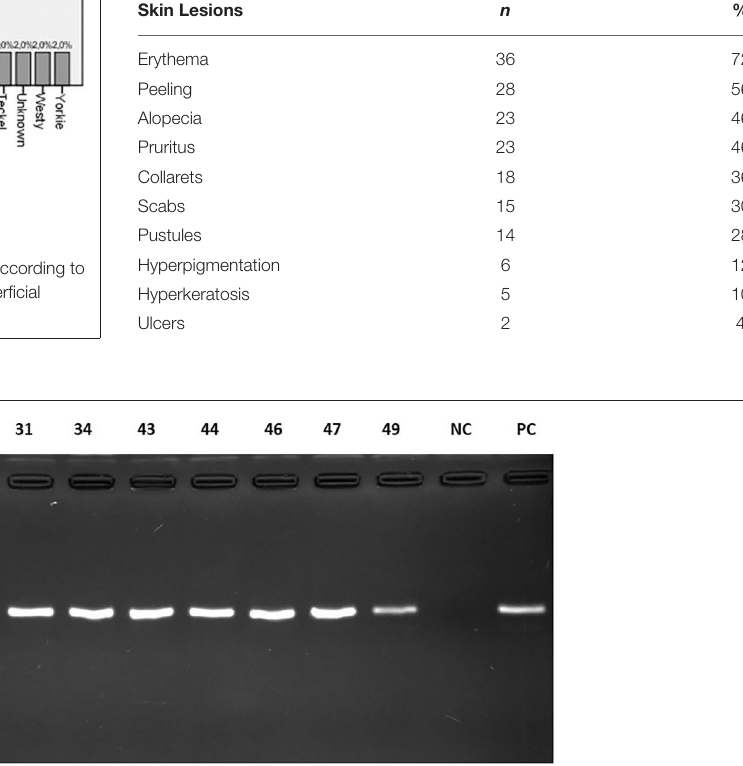
Frontiers in Veterinary Science |